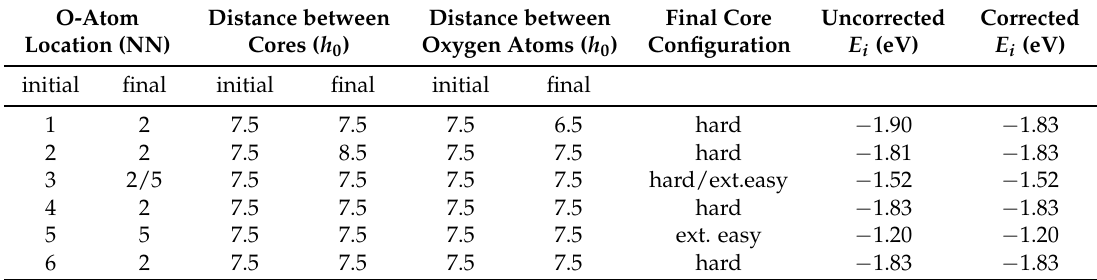
Table A1. Details of the calculations of the dislocation–O atom interaction energies for the six tetrahedral configurations considered in Figure 2. The first two columns specify the relative core–O atom positions before and after relaxation. The third and fourth columns indicate the distance between the two dislocation cores before and after relaxation in units of the periodicity of the Peierls potential, √ h 0 = a 0 6/3 (equal to the length of the triangles in Figures 2 and 8). For example, 7.5 h 0 ≈ 19.5 Å. Columns 5 and 6 give the distance between the oxygen atoms before and after relaxation, also in units of h 0 . The next column gives the structure of the dislocation cores obtained after relaxation (refer to Figure 8 for visual guidance). Finally, the last two columns give the uncorrected and corrected interaction energies in each